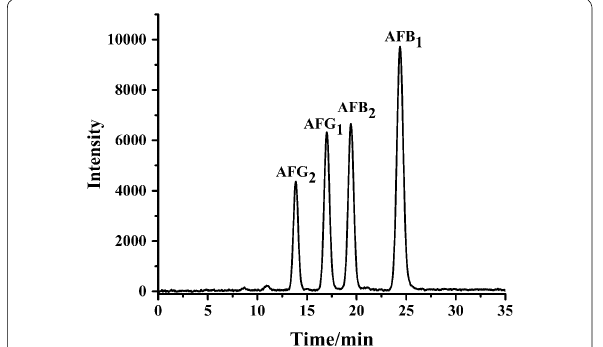
Fig. 5 HPLC-PCD-FLD chromatogram of four aflatoxins